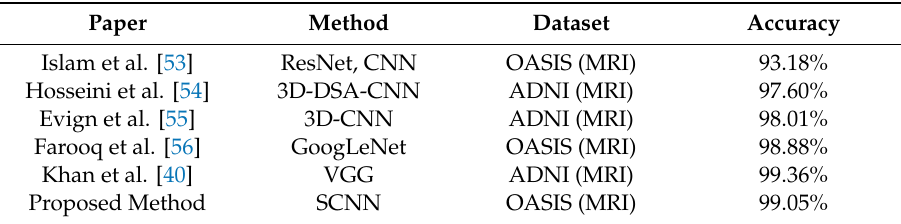
Table5. Comparisonofaccuracyvalueswithstate-of-the-arttechniquesappliedtodiagnoseAlzheimer’s disease